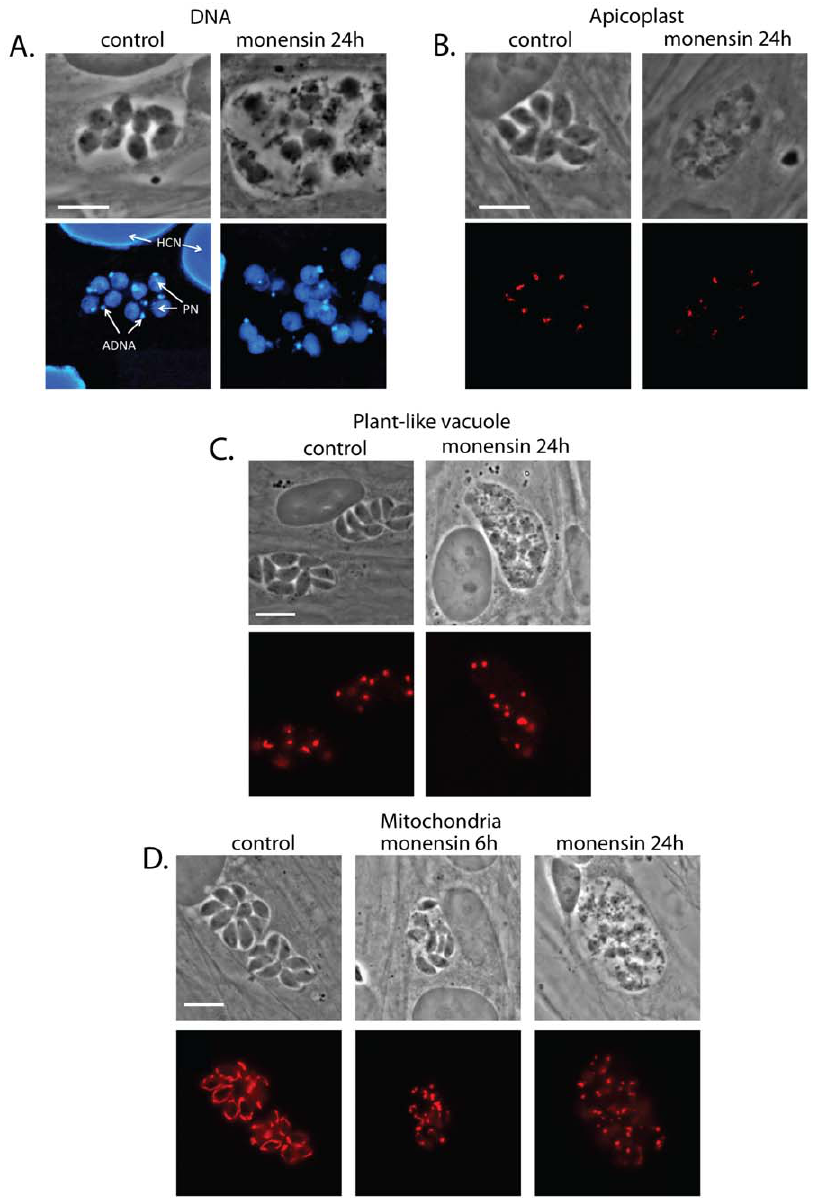
Figure 3. Monensin affects mitochondrial morphology. Phase-contrast and deconvolved immunofluorescence micrographs showing effect of monensin (0.75 ng/ml, 24 hours) on several T. gondii intracellular structures. (A) Phase contrast and DAPI staining of DNA showing parasite nuclei (PN) and apicoplast DNA (ADNA). HCN=host cell nuclei. (B) Phase contrast and immunofluorescence staining showing Atrx1 protein in the apicoplasts. (C) Phase contrast and immunofluorescence staining of TgNHE3 showing parasite plant-like vacuoles. (D) Phase contrast and immunofluorescence showing parasite mitochondria. Scale bars=10 m m.